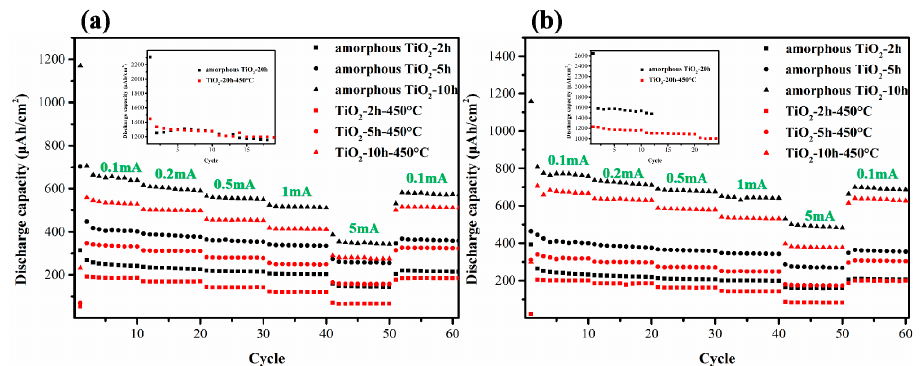
Figure 10. Cycling stability and rate performances of amorphous and anatase TiO 2 nanotubes with different anodizing times (2, 5, 10 h (inserts: 20 h)) under different current densities and different NH 4 F contents in TiO 2 nanotubes growth: ( a ) 0.2 wt%, ( b ) 0.5 Table 1. Relationship between the second discharge capacity and the diameter/length of the nanotubes.